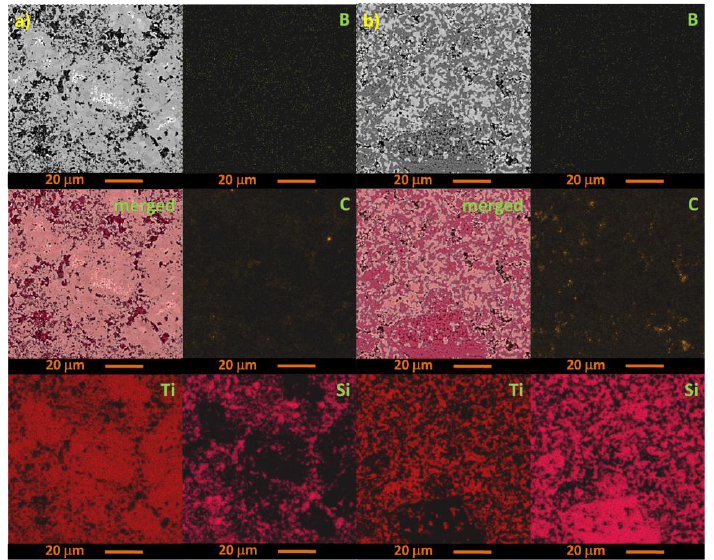
Figure 7. SEM elemental maps for B, C, Ti, and Si showing the microstructures of the composites: ( a ) stochiometric addition of TiSi 2 ( b ) stochiometric addition of Ti 5 Si 3 . The SEM images showing the microstructures of composites with TiSi 2 and Ti 5 Si 3 ad- ditives are shown in Figures 8 and 9, respectively. Both additives act similarly, the greater the molar fraction of the elements incorporated into the composites, the greater the oc- curred areas of the new phases. Samples with the Ti 5 Si 3 additive tend to have less porosity than the samples with the other additives. Samples with the stochiometric addition of TiSi 2 and Ti 5 Si 3 are more homogenized than the composites with a smaller percentage of addi- tives.